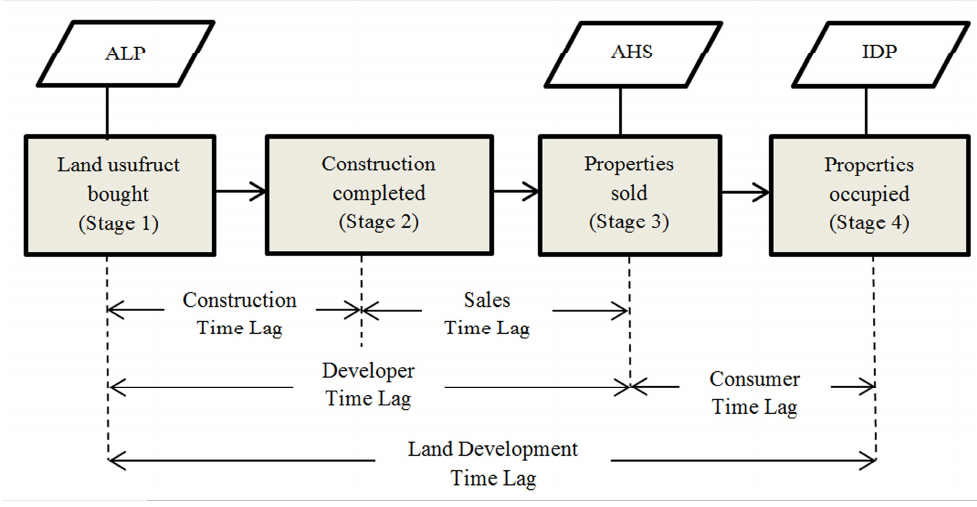
Figure 5. The procedure of real estate land development in China and the potential time lags at each stage of the